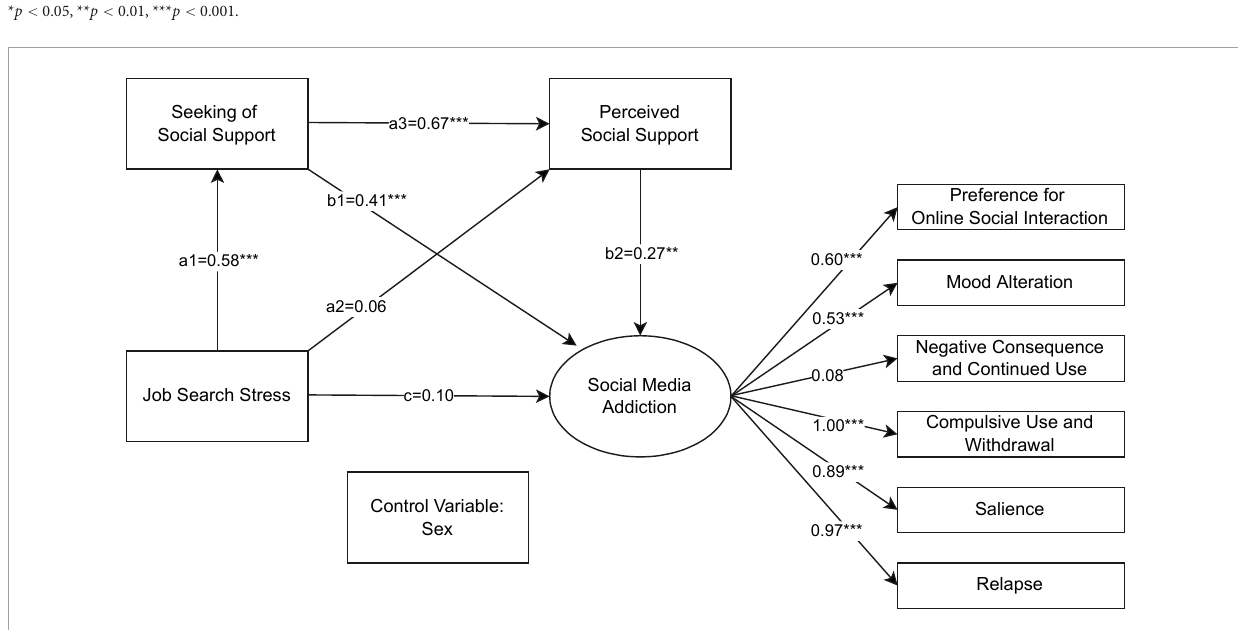
FIGURE1 Structural equation model denoting the relation between job search stress and social media addiction after controlling for gender. Standardized coefficients are reported. * p < 0.05, ** p < 0.01, *** p <